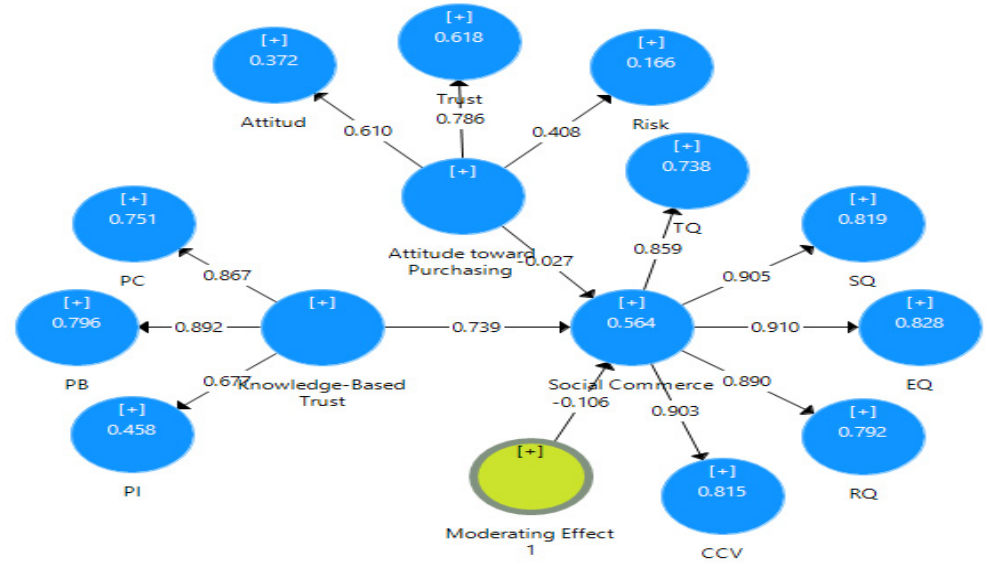
Fig. 4: Structural model in the standard estimation mode